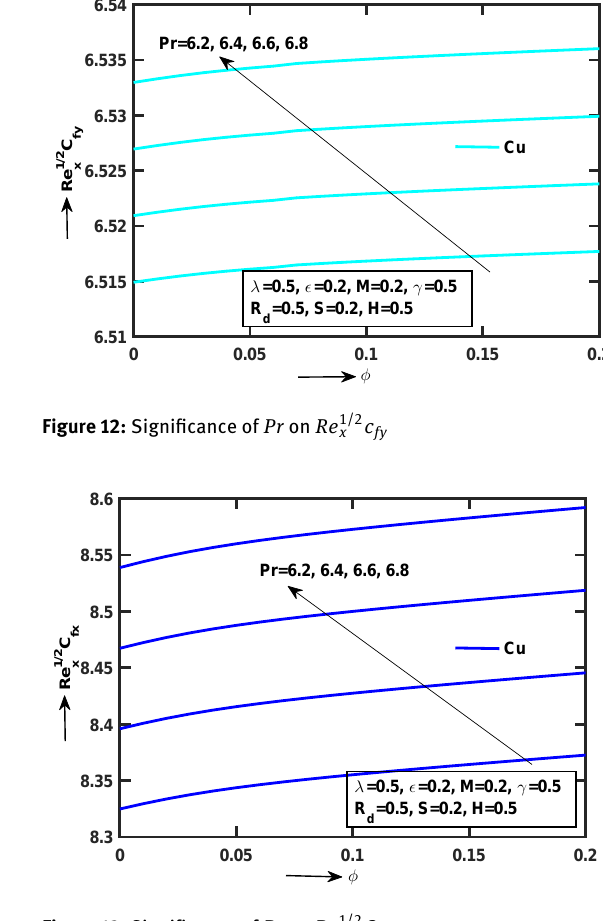
Figure 13: Significance of Pr on Re